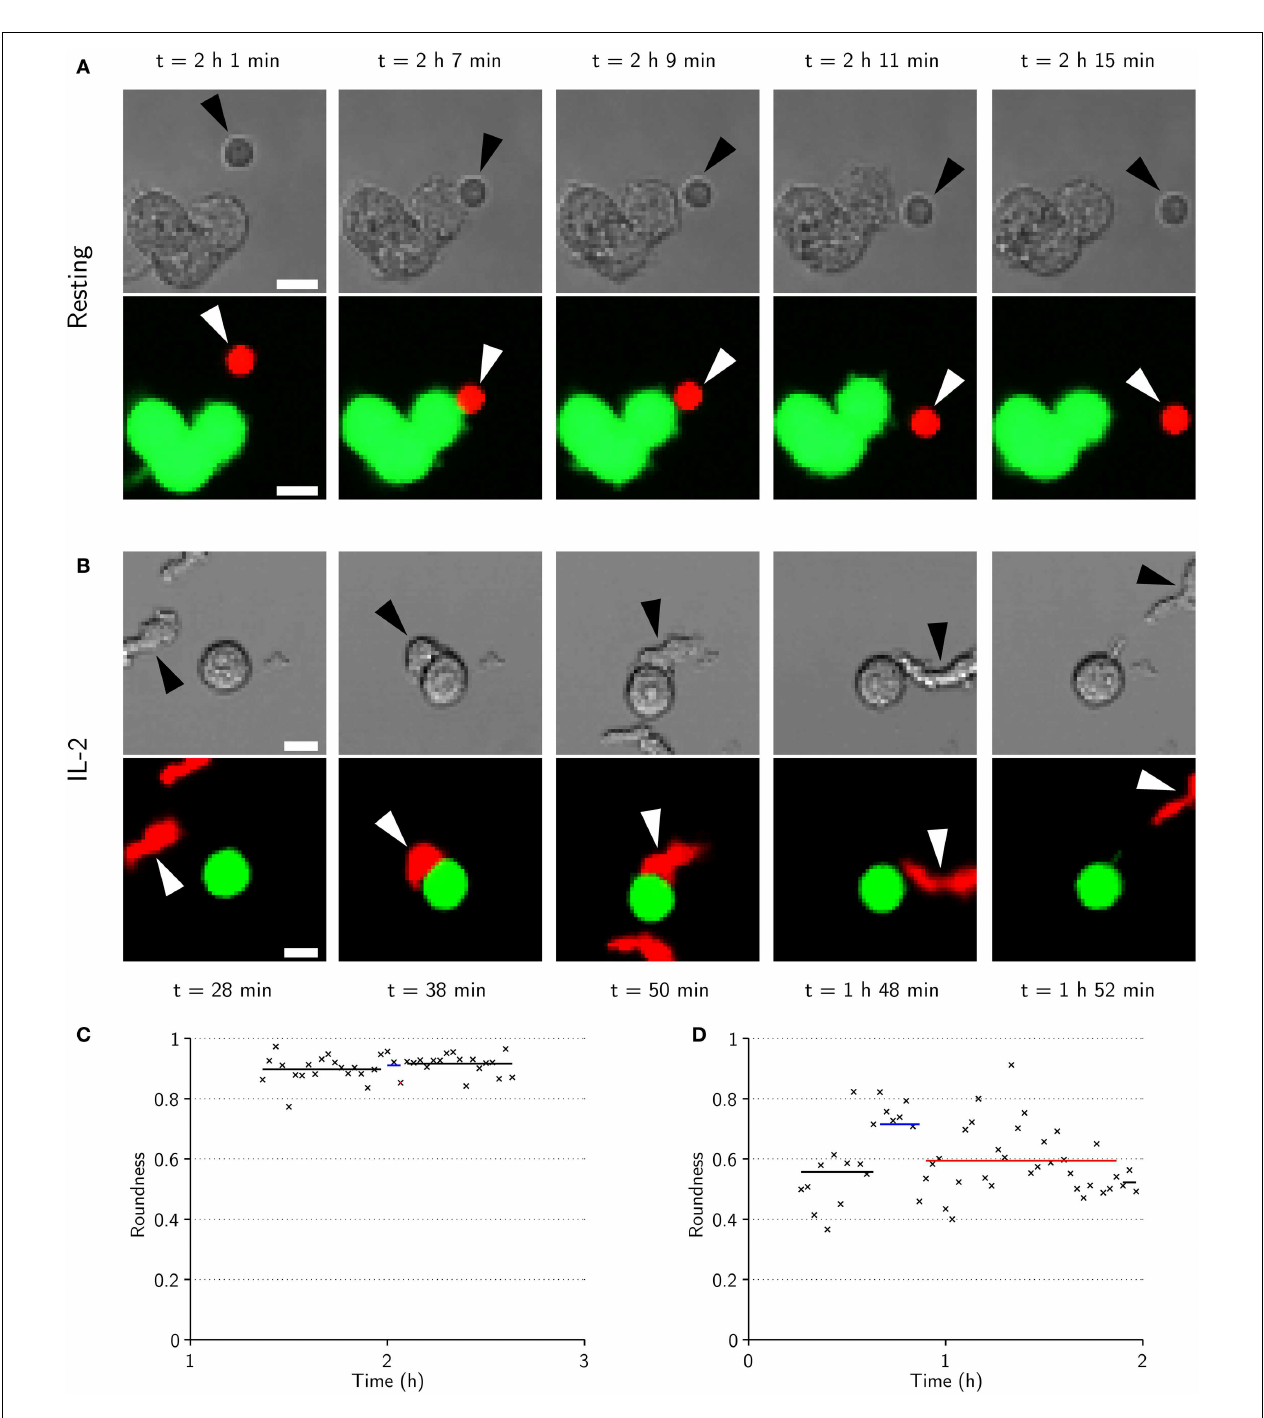
Scale bars indicate 10 µ m. (B) Same as in (A) but for an activated NK cell. The NK cell approaches a target cell ( t = 28min) and forms a conjugate ( t = 38min) that ends as the NK cell assumes a migratory morphology ( t = 50min).The NK cell remains attached to the target cell for almost an hour before it detaches ( t = 1h 48min) and migrates away from the target cell ( t = 1h 52min). (C) NK cell roundness vs. time for the sequence shown in (A) . (D) NK cell roundness vs. time for sequence shown in (B) . Shown are also mean roundness in conjugation (blue lines), attachment (red lines), and free migration (black